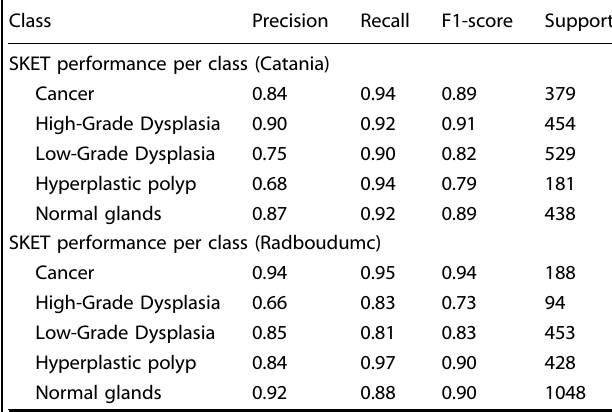
Table 7. Overview of SKET performance, reporting the precision, the recall and the F1-score of the single classes, in both Catania and Radboudumc